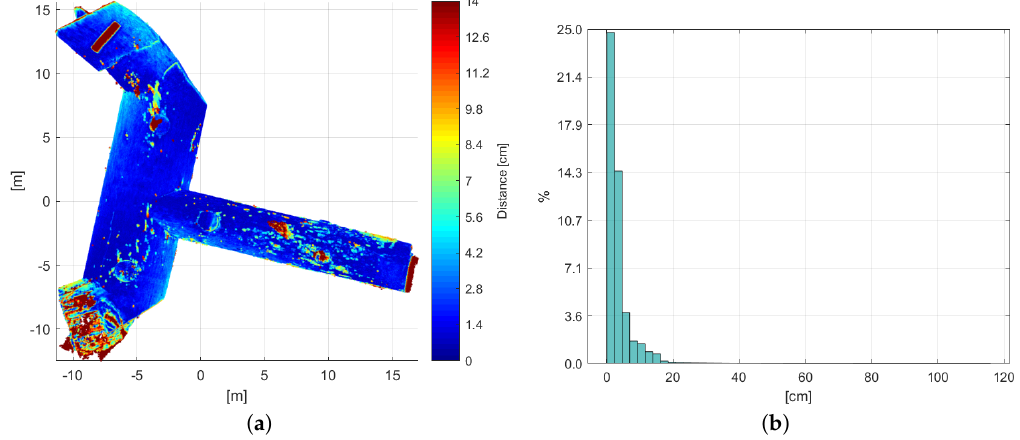
Figure 7. Photogrammetric 3D model accuracy assessment: comparison with the TLS 3D model. Point clouds registered in local coordinates with the ICP algorithm. ( a ) Map of point-to-point distances. ( b ) Histogram of distances shown in ( a ).